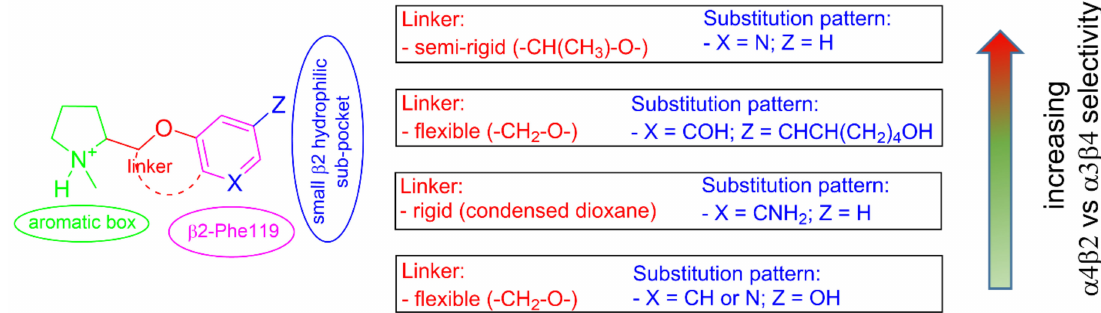
Figure 12. Crucial observations regarding α 4 β 2 vs. α 3 β 4 selectivity. Supplementary Materials: Table S1: Overview of the relevant interactions of the compounds ( S )- nicotine , A - 84543, and AT - 1001 reported in Figure 4; Table S2: Overview of the relevant in- teractions of the compounds ( S )- 3 – 7 reported in Figures 5 and 6; Table S3: Overview of the relevant interactions of the compounds ( S )- 8 – 14 reported in Figure 7; Table S4: Overview of the relevant interactions of the compounds ( S )- 15 and ( S )- 16 reported in Figure 8; Table S5: Overview of the relevant interactions of the compounds ( S , R )- 2 , ( S , R )- 26 , ( S , R )- 29 , ( S , R )- 31 , and ( S , S )- 37 – 40 reported in Figures 9 and 11, respectively; Table S6: Overview of the relevant interactions of the compounds ( S , R )- 33 – 36 reported in Figure 10; Table S7: RMSD values from the self-docking